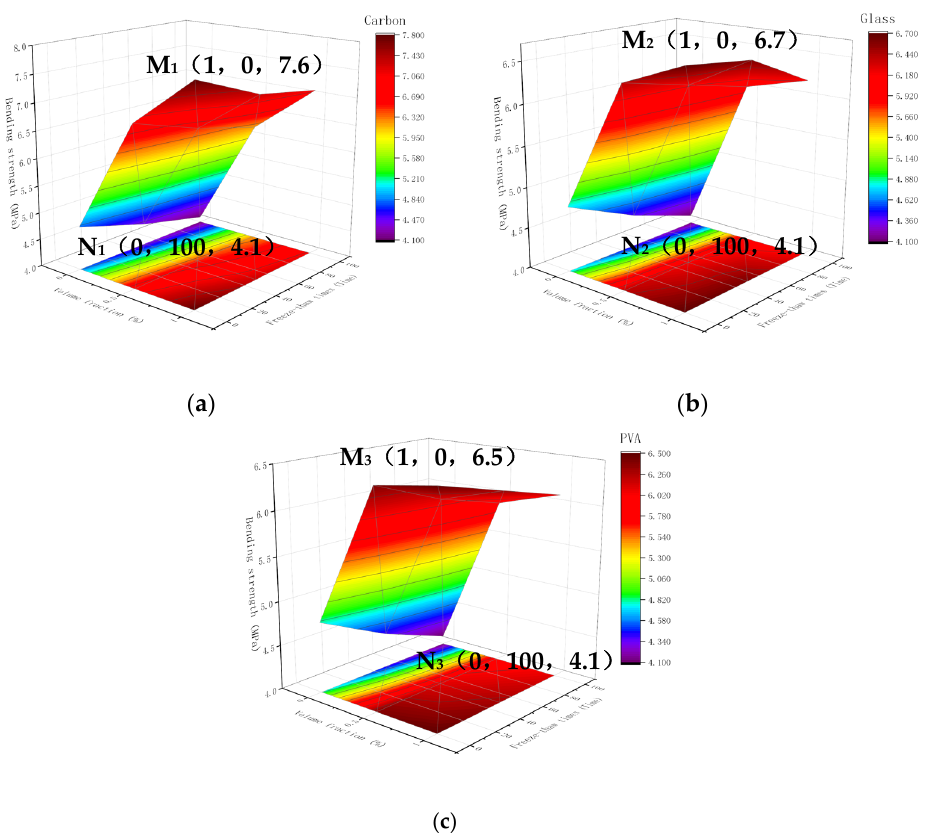
Figure 11. 3D surface map with projection: ( a ) Carbon fiber bending resistance; ( b ) Glass fiber bending resistance; ( c ) PVA fiber bending resistance.